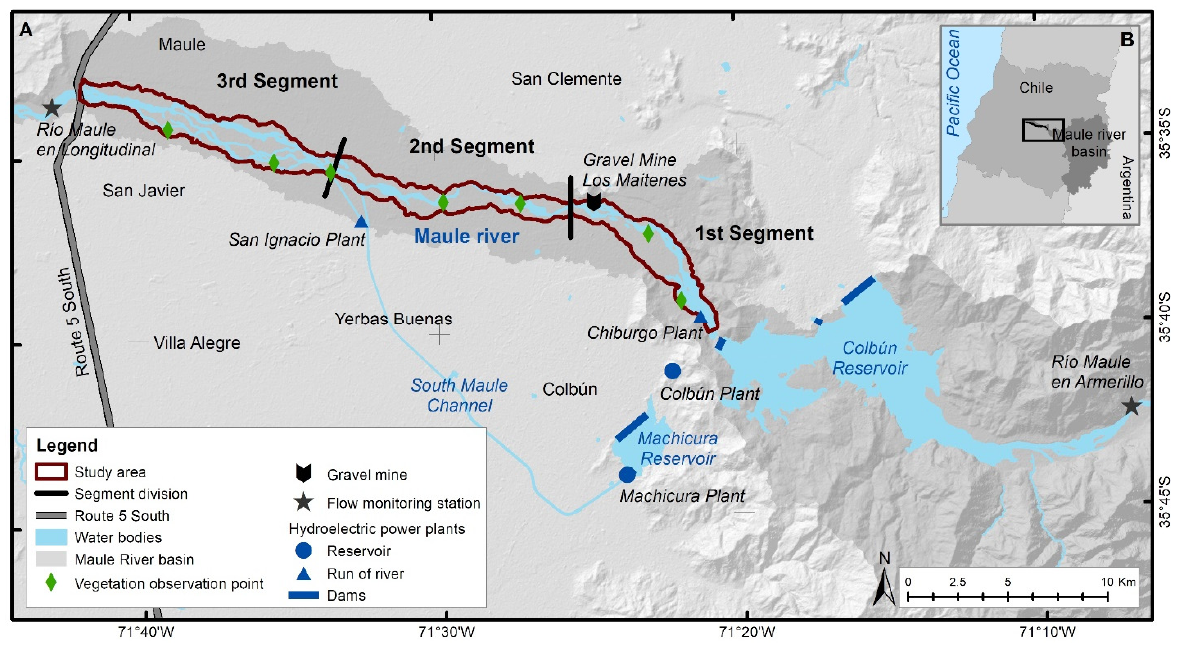
Figure 1. Study area. ( A ) The three studied river segments, locations of the main hydroelectric power plants, and vegetation sampling points. ( B ) Regional context of the basin. Table 1. Characteristics of the plants of the Colb ú n–Machicura hydroelectric complex.